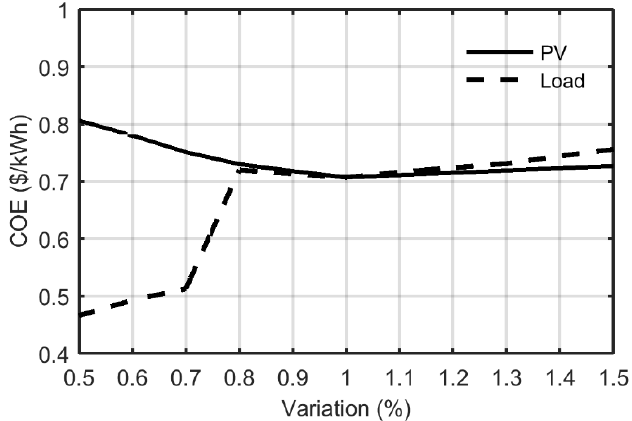
Figure 14. PV and load impact upon LCOE.